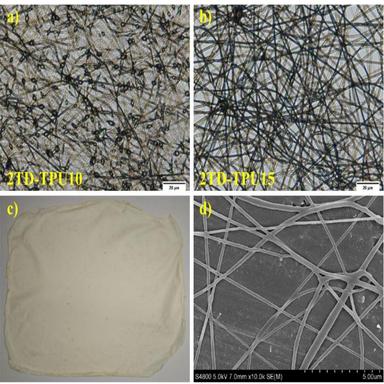
Optical microscopy images at a magnification of 50x of: a) 2TD-TPU10 and b) 2TD-TPU15. c) Digital image of the electrospun mat from 2TD-TPU15 (sample size 10 cm x 7.5 cm) and d) SEM image of the obtained 2TD-TPU15 mat.